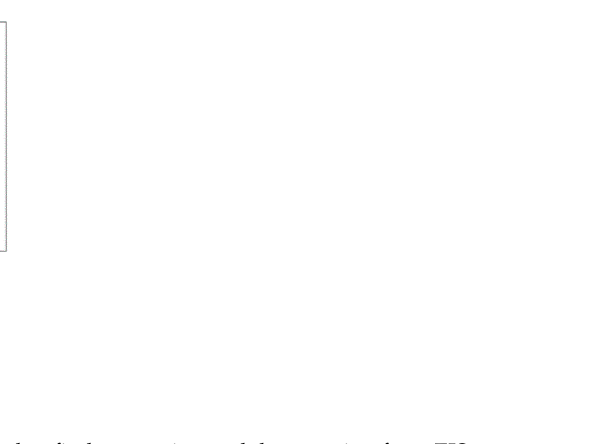
Figure 10. Equivalent circuit employed to fit the experimental data coming from EIS test. Table 2. Results of the fitting of the experimental data coming from EIS tests.